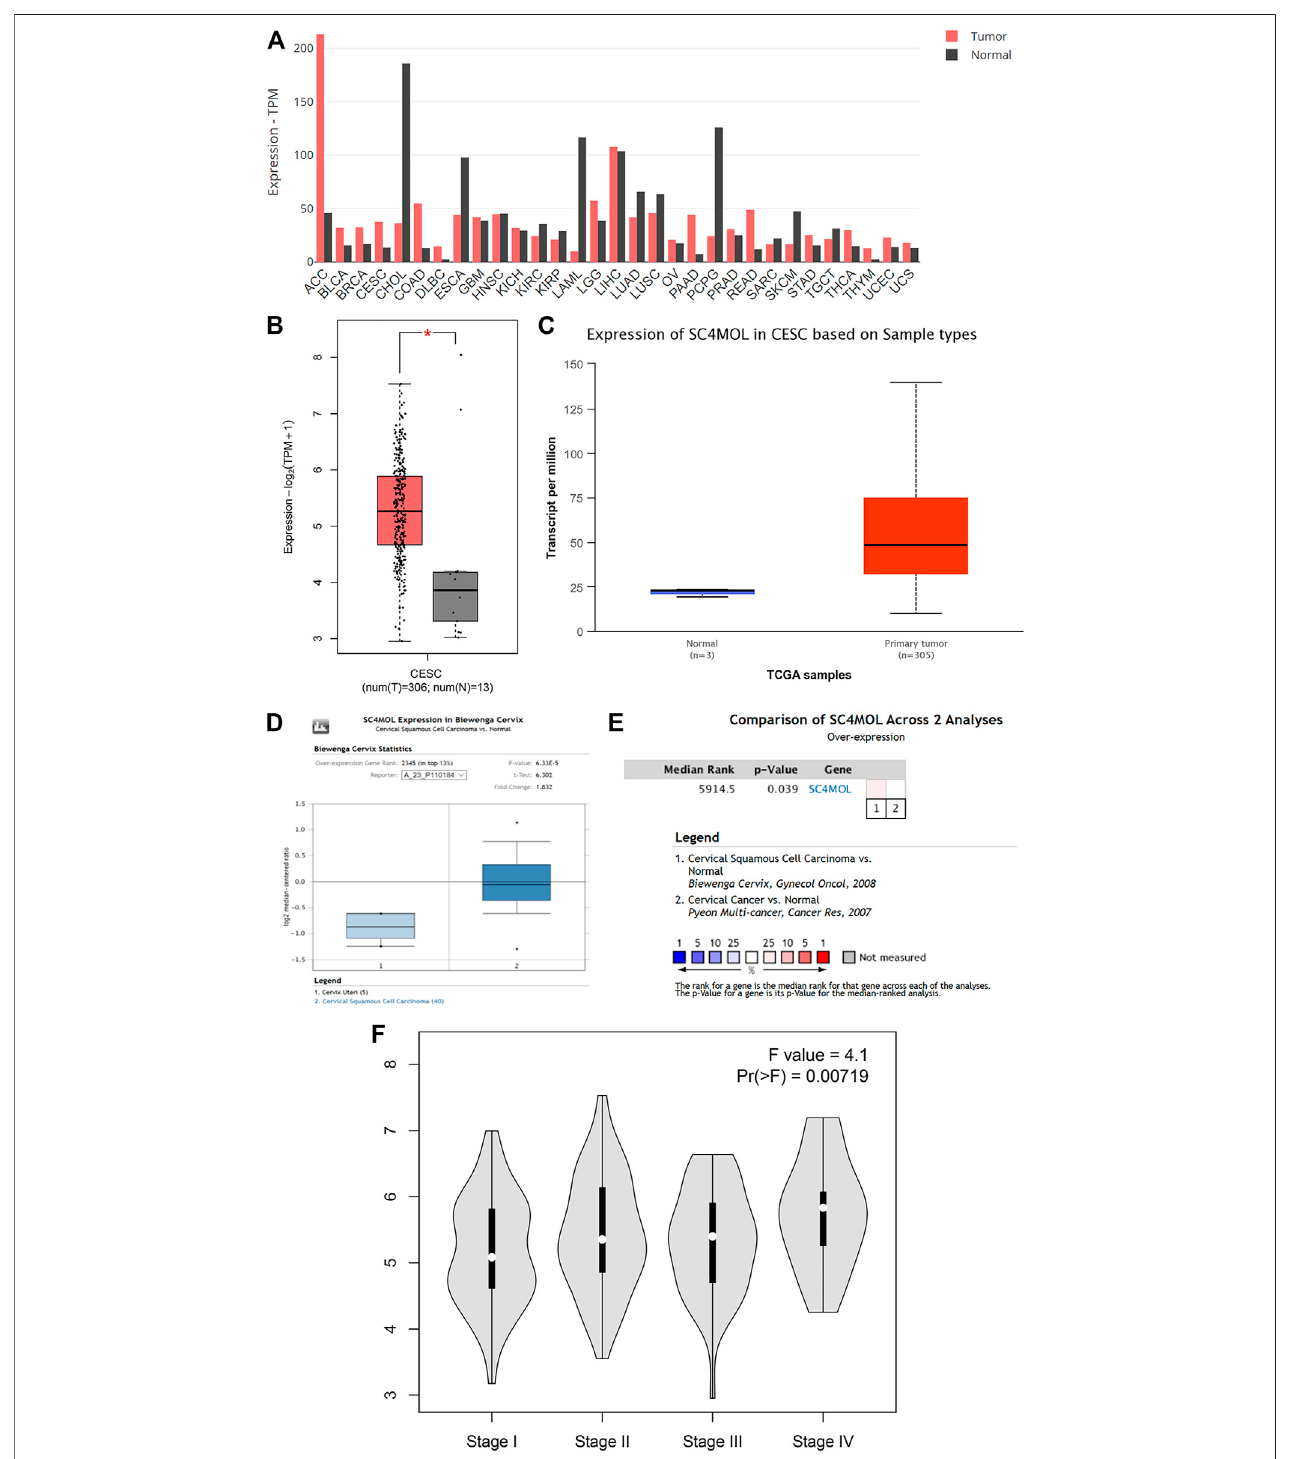
FIGURE2| DifferentialexpressionofMSMO1inCESC. (A) DifferentialexpressionofMSMO1in31cancerspeciesofGEPIA2. (B) ExpressionDifferenceDiagramof MSMO1 in CESC shown in GEPIA2. (C) Expression Difference Diagram of MSMO1 in CESC shown in UALCAN. (D) In Oncomine MSMO1 (SC4MOL) gene expression comparison between normal and cancerous tissues in the Biewenga Cervix data set. (E) Comparison of Biewenga Cervix and Pyeon Multi-cancer data sets. (F) The violin expression diagram of MSMO1 gene in GEPIA2 in different stages of CESC.